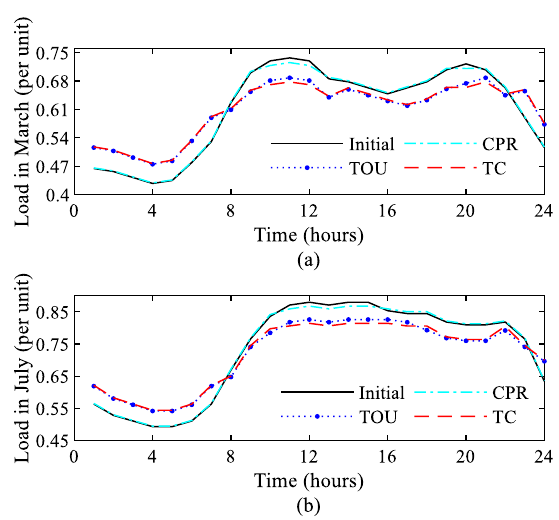
Fig. 11 Load curves before and after CPR: a March; b July